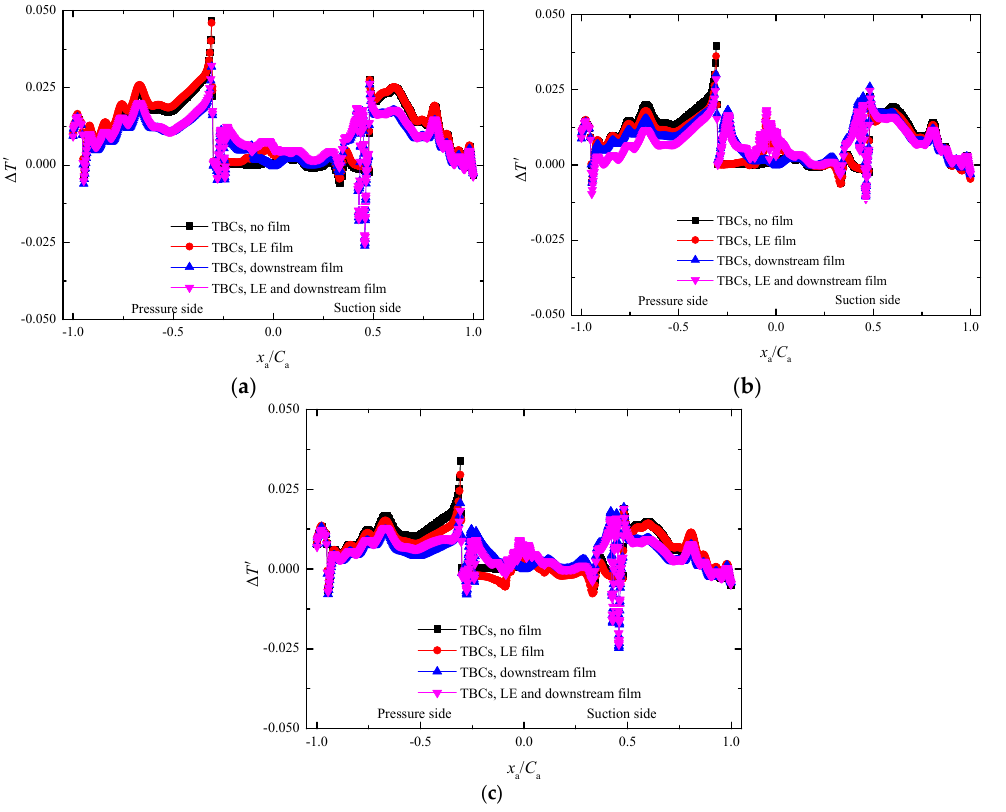
Figure 10. Relative temperature change comparisons for different cases. ( a ) z = −19.3 mm, ( b ) z = 0 mm, ( c ) z = 19.3 mm.